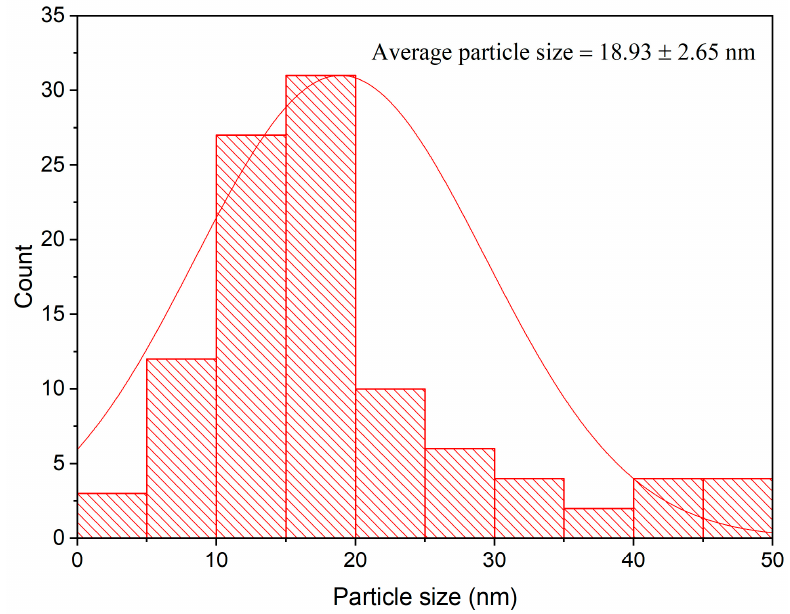
Figure 6. Particle size distribution histogram of ZnO-NPs.